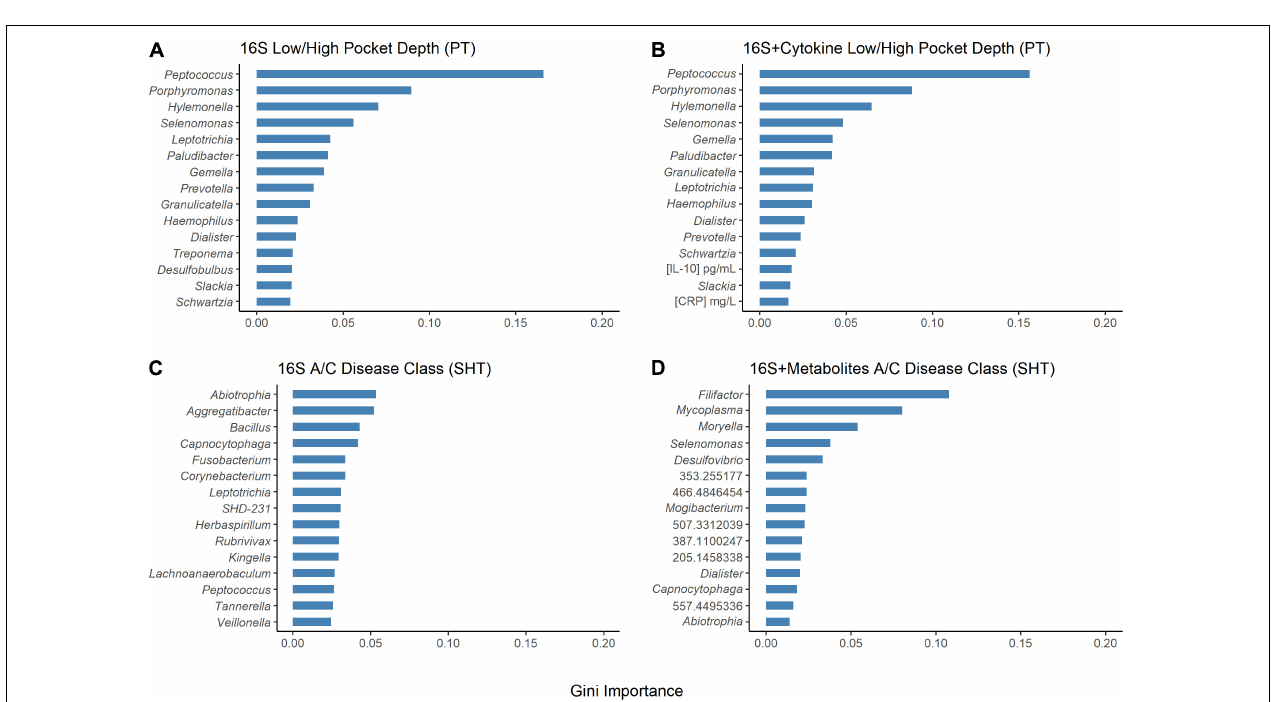
FIGURE 5 | Results of random forest Gini importance bar plots. Periodontal treatment (PT) dataset high/low periodontal disease (PD) using (A) 16S and (B) 16S and cytokines. Sodium hypochlorite (SHT) dataset A/C disease classes (C) 16S and (D) 16S and metabolites. Larger Gini importance indicates that features can resolve more nodes in decision trees with more